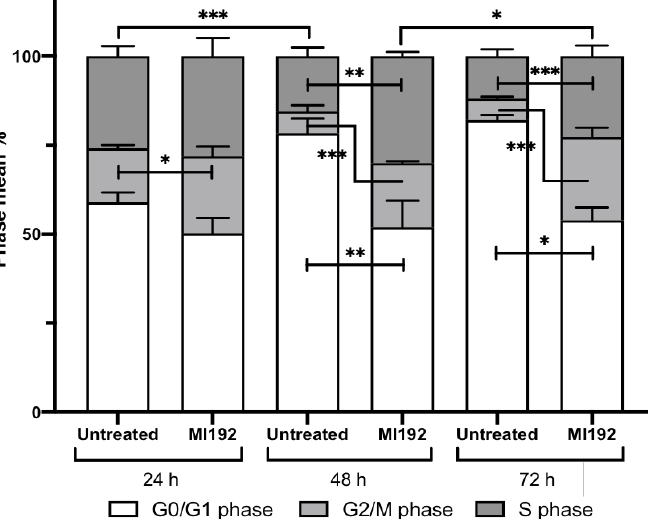
Figure 4. Effects of MI192 treatment on hDPSCs cell cycle progression. Data are expressed as mean ± SD ( n = 3). The significance levels shown are the test group compared to the basal control for that time point. * p ≤ 0.05, ** p ≤ 0.01 and *** p ≤ 0.001.